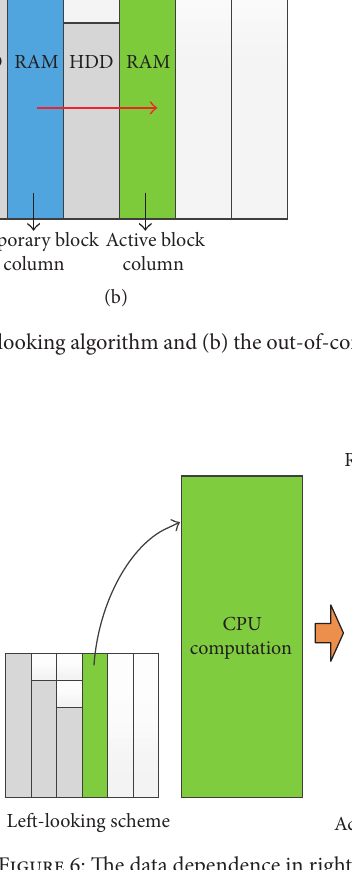
Figure 6: The data dependence in right-looking